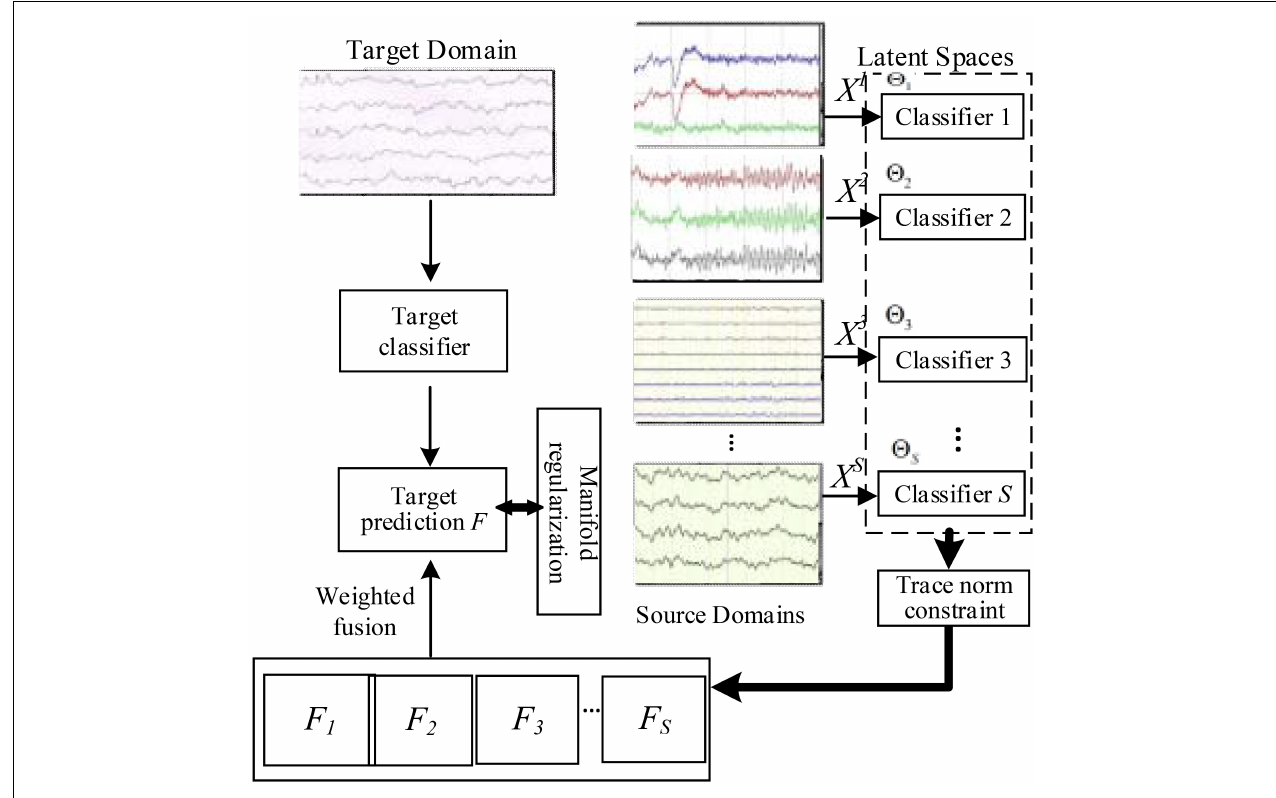
FIGURE 1 | Flowchart of LMA on EEG-based emotion